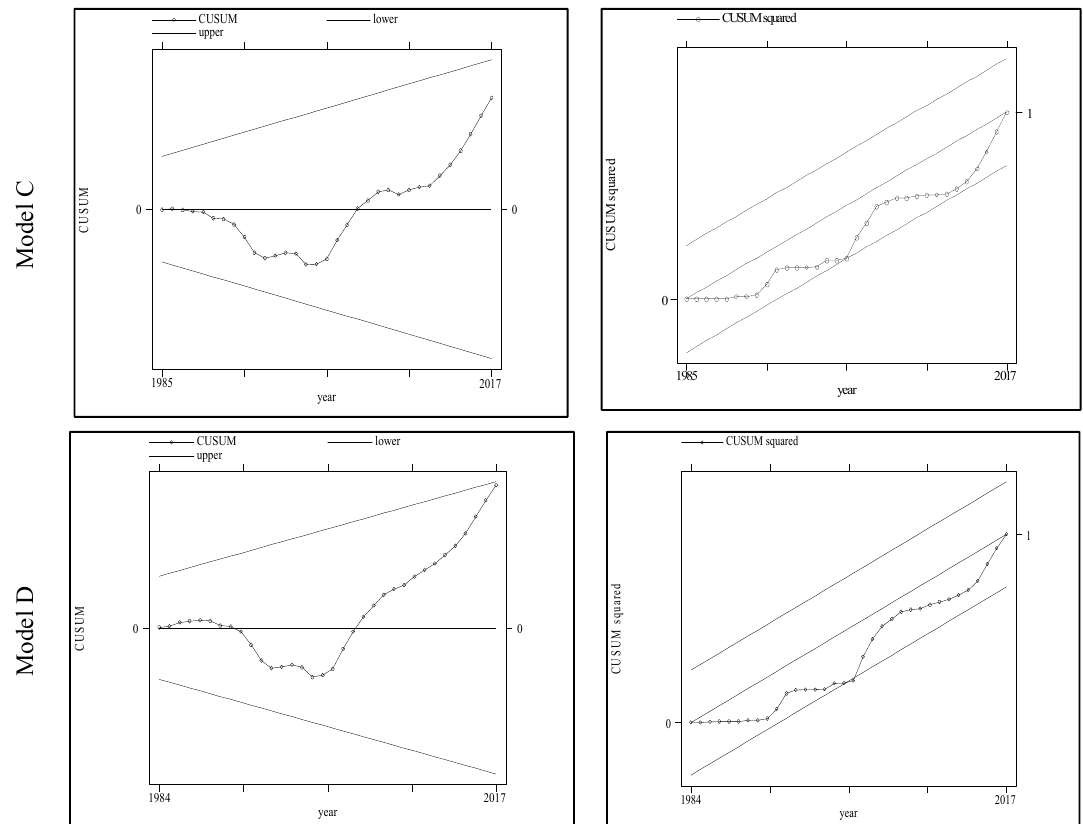
Figure 2. Plots of cumulative sum of recursive residuals (CUSUM) and CUSUM squared for the four models. Note: Upper and lower limits at 95% confidence interval.